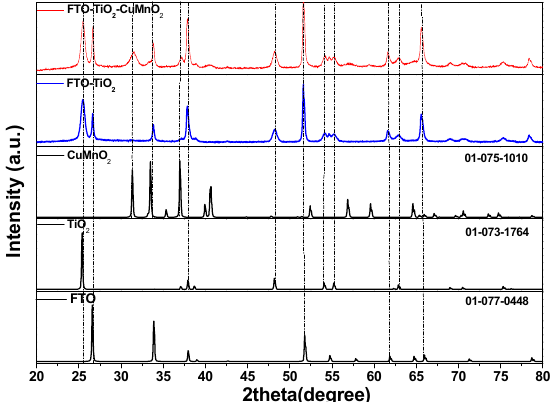
Figure 2. X-ray patterns for the FTO-TiO 2 -CuMnO 2 heterostructures.